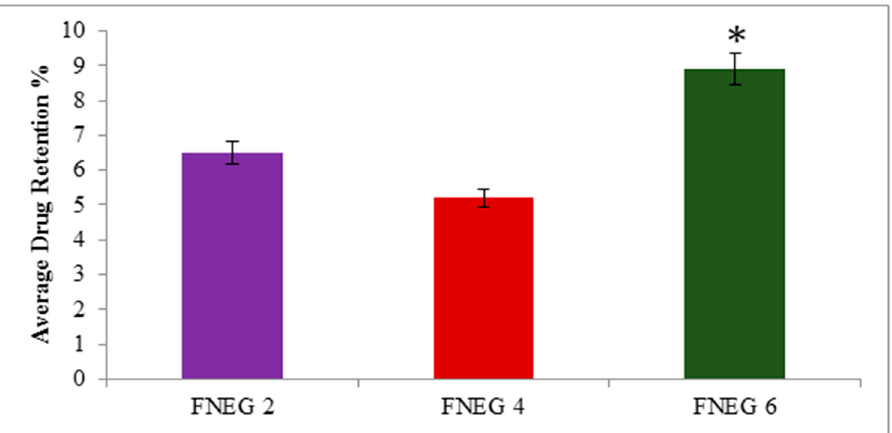
Figure 9. Methotrexate concentrations in the dermal layer of skin from methotrexate-loaded nanoemulsion gel formulations (FNEG2, FNEG4, and FNEG6), respectively, calculated from in vivo studies (* p < 0.001). Table 7. Storage stability of methotrexate nanoemulsion gel formulation (FNEG6) at refrigerated and accelerated temperatures for 60